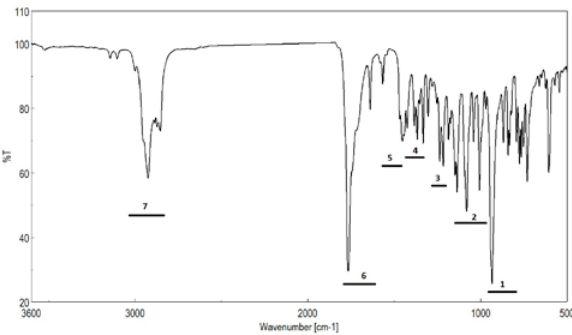
Figure 1. ATR-MIR spectra registered for sample 3 ( SFE extraction with CO 2 ).